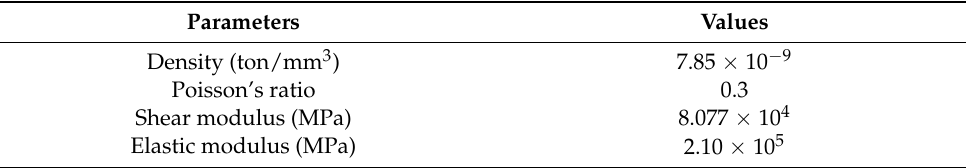
Table 1. Material properties of the cross